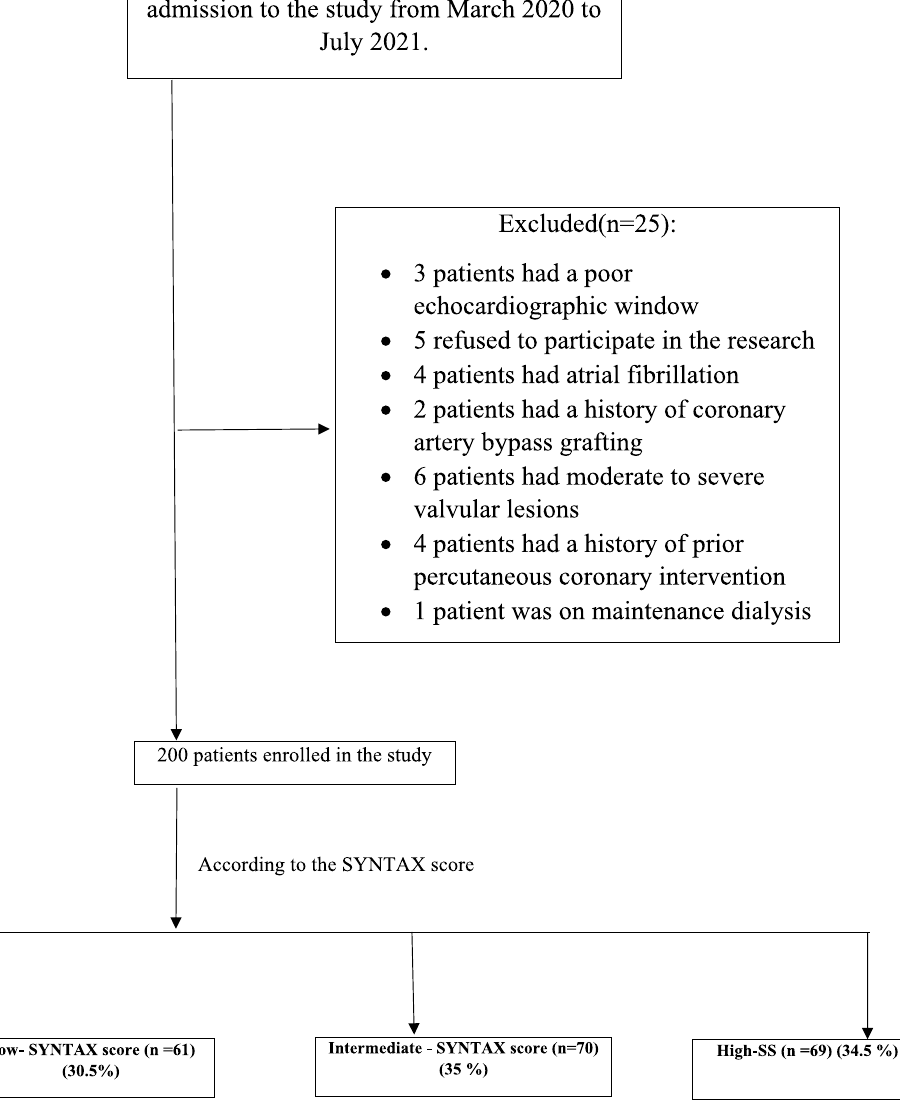
Fig. 1 Flowchart of the patients included in the